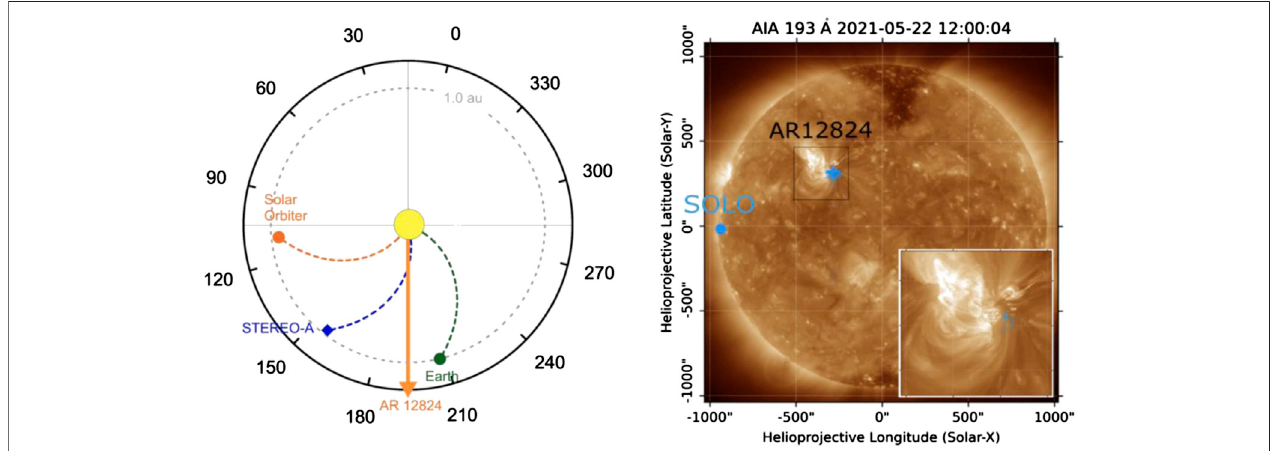
FIGURE 1 | Left : spacecraft constellation on 22 May 2021, showing location of AR 12824 and nominal magnetic connections for a 400 km/s solar wind. Right: SDO-AIA EUV image: circle at left is Solar Orbiter subsolar point; blue crosses near AR mark connection locations throughout the study period with the insert showing a zoom in view of the region (see text for details).